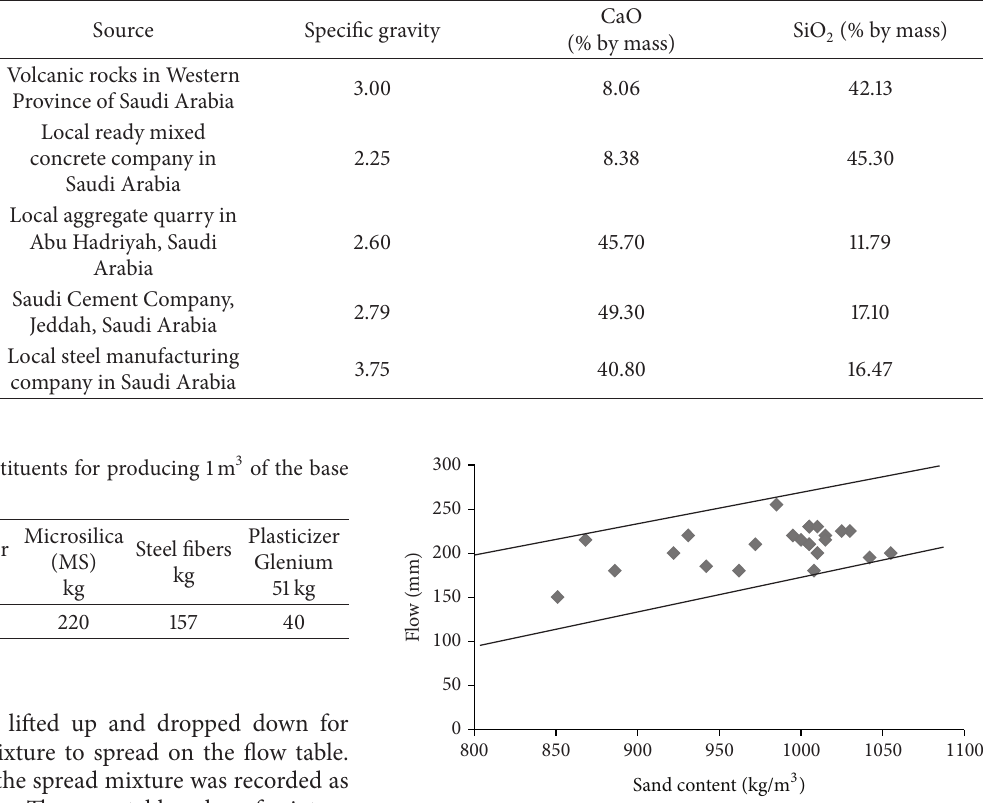
Table 5: Details of the materials used as partial replacements of microsilica and sand.